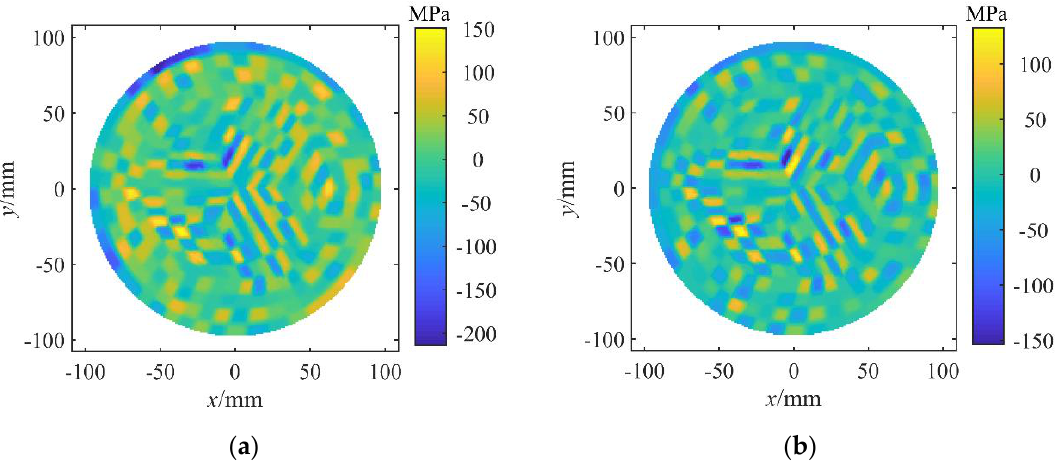
Figure 6. Residual stress distribution ( a ) calculated from wafer deformation with random errors and its difference ( b ) from Figure 4. The residual stress changed significantly while the change of the wafer deformation was very limited.